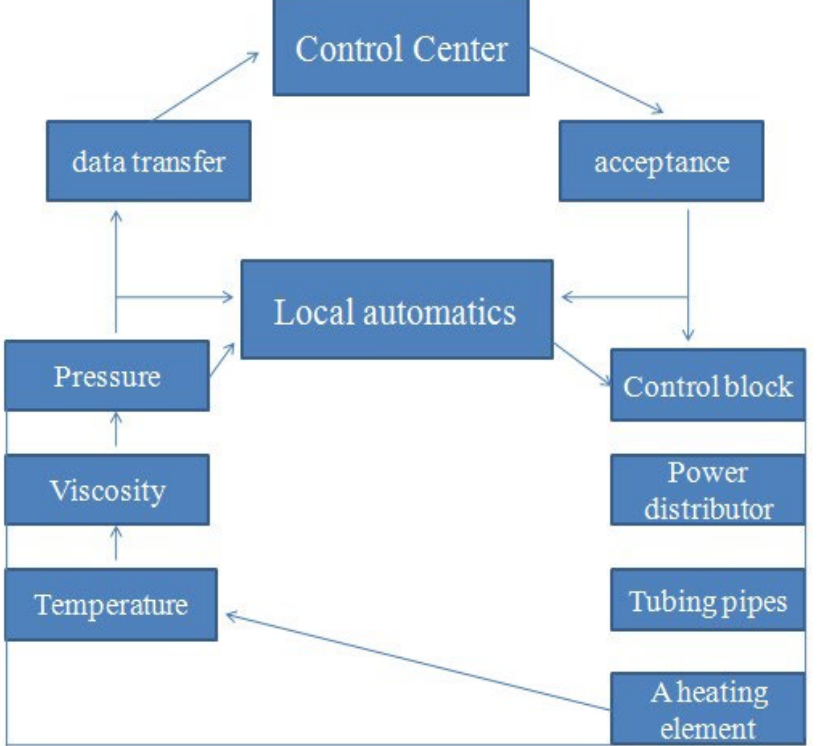
Figure 3. Scheme of information flows in the oil and gas production department in terms of tech- nological complexes for oil production.